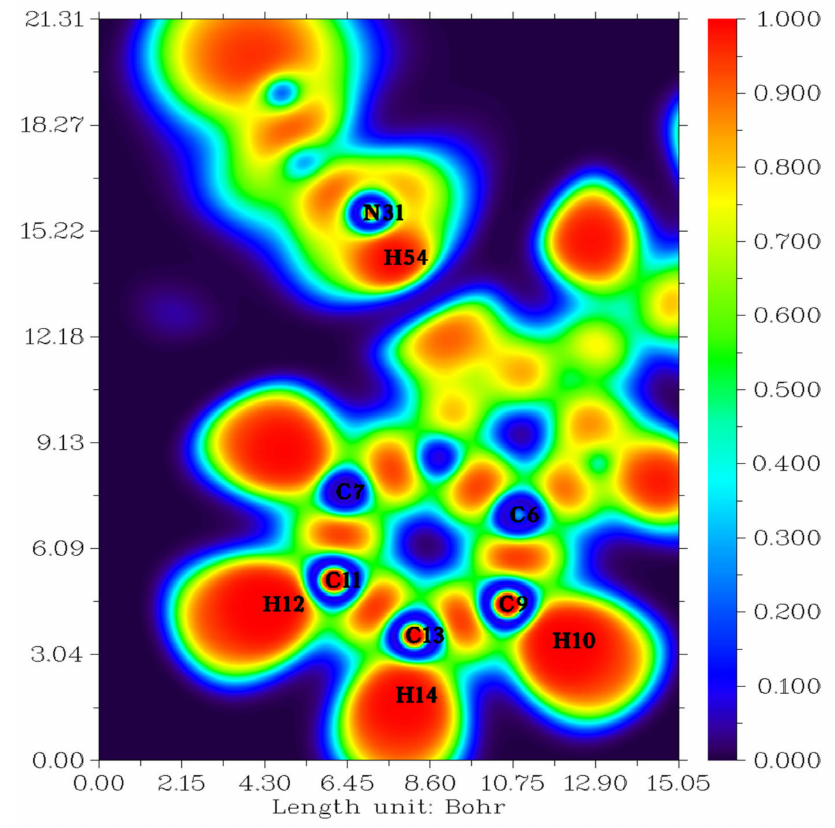
Figure 3. Electron localization function (ELF) map of the title